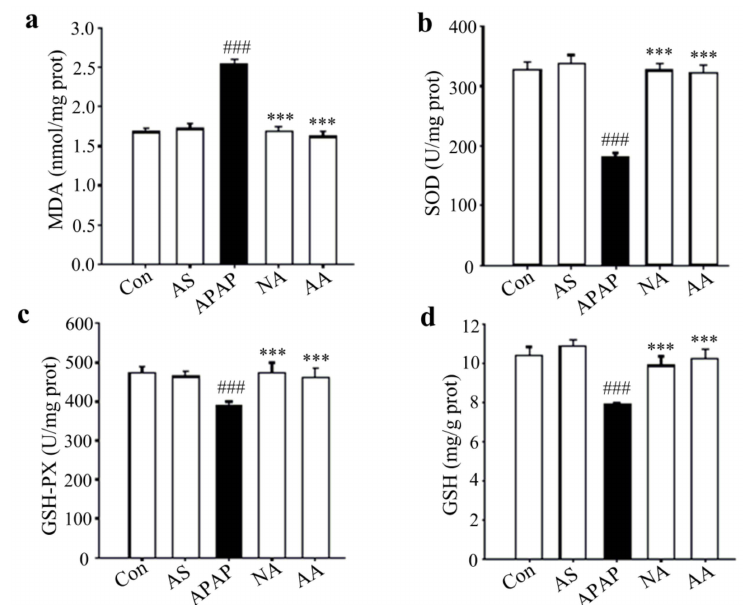
Figure 5. AS decreases hepatic oxidative stress in APAP-induced hepatotoxicity mice. ( a ) Hepatic MDA levels. ( b ) Hepatic SOD activities. ( c ) Hepatic GSH-PX activities. ( d ) Hepatic GSH levels. Data are expressed as means ± SD ( n = 10). ### p < 0.001 compared to the Con group; *** p < 0.001 compared to the APAP group.